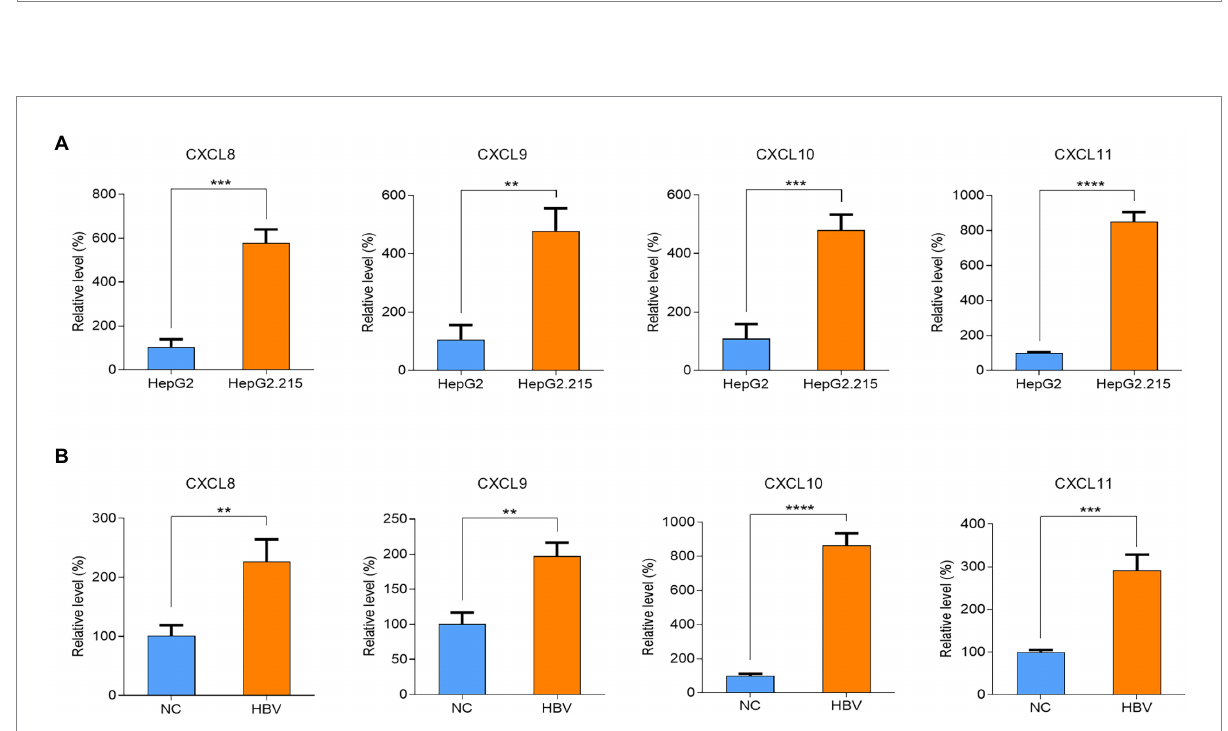
FIGURE 2 Differences of CXCL8, CXCL9, CXCL10 and CXCL11 mRNA levels after HBV infection. (A) Validation of CXCL8, CXCL9, CXCL10 and CXCL11 mRNA levels. (B) Validation of CXCL8, CXCL9, CXCL10 and CXCL11 mRNA levels after transfection with HBV plasmid. NC refers to HBV control plasmid, HBV refers for HBV 1.3-mer WT replicon plasmid. ** p < 0.01, *** p < 0.001, **** p < 0.0001.